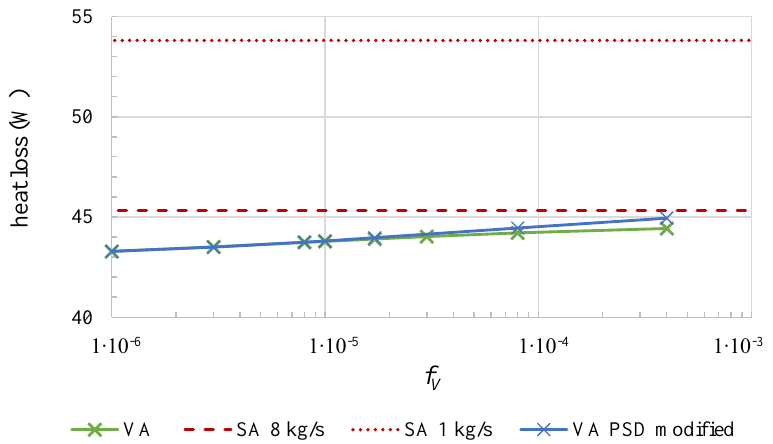
Figure 5. The heat loss is shown as a function of the nanoparticle volume fraction f V . The red dashed and dotted lines show the heat loss for the SA, whereas the solid lines describe the VA at two different mass flow rates,